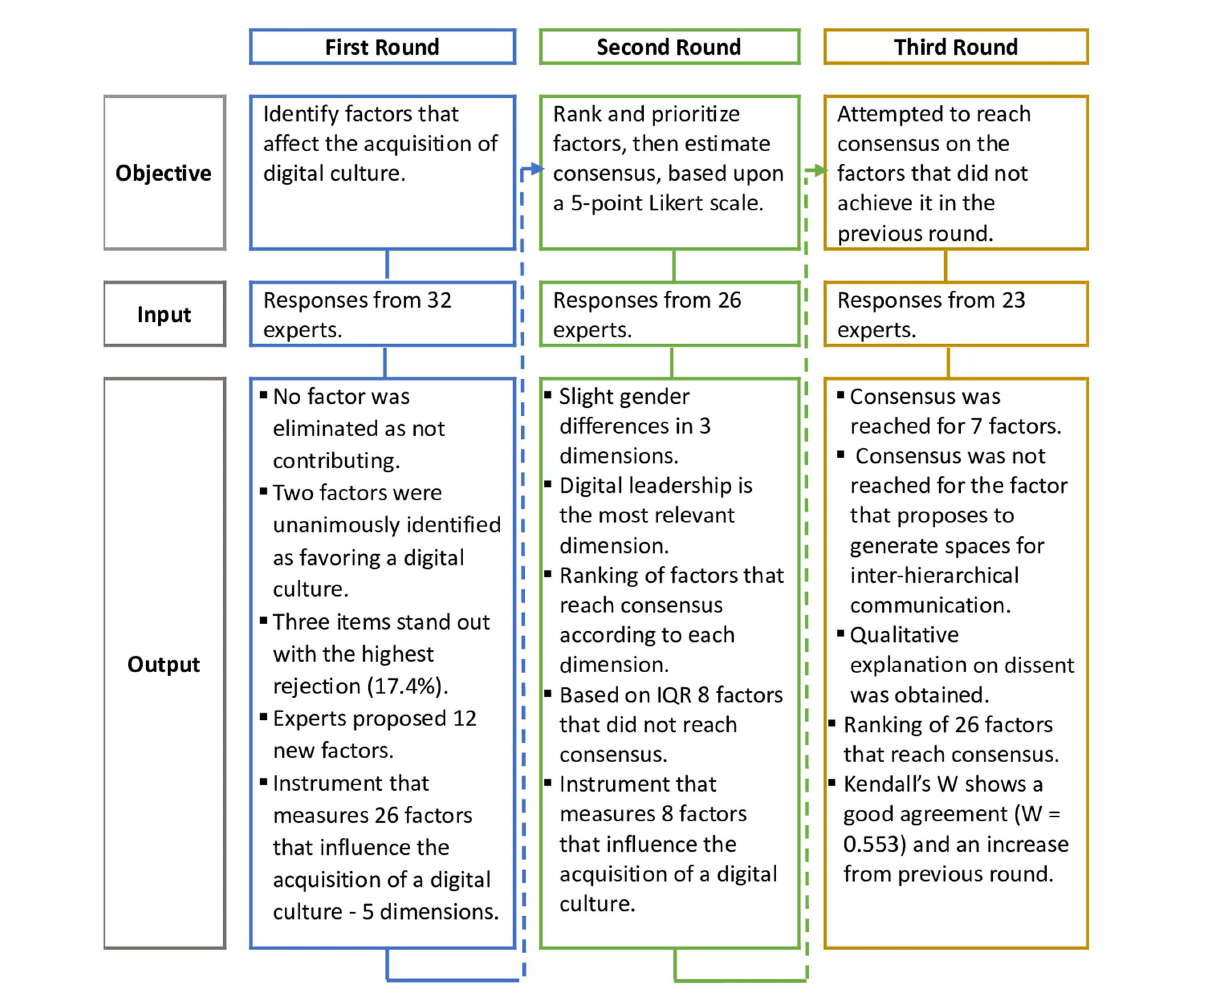
FIGURE 2 Objectives, inputs, and outputs for all three